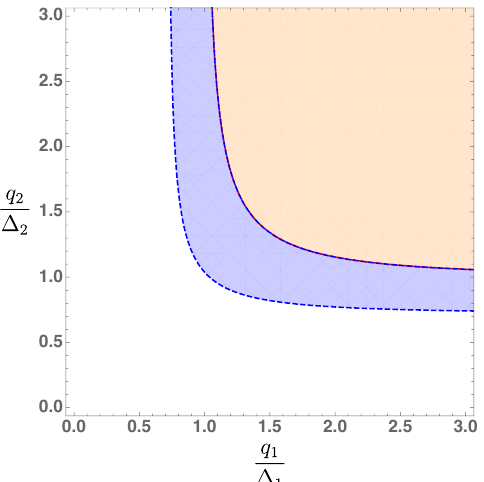
Figure 8 . The weak gravity bound (4.4) is satis(cid:12)ed in the orange region. The boundary of the blue region denotes the stability boundary (for (cid:1) 1 = (cid:1) 2 = 2) in the sense that the solutions remain stable for all a < a max only for charges below (or to the left of) this boundary. Since these regions do not intersect, our solutions always become unstable before reaching a max